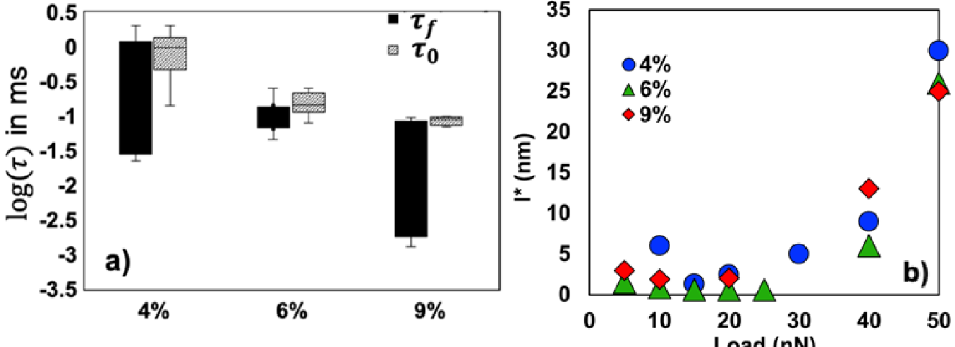
Figure 12. Parameters of the viscous-adhesive friction model for PAAm hydrogels (adhesive component). ( a ) Characteristics times for bond formation and rupture ( 𝜏 𝑓 and 𝜏 0 , respectively) in logarithmic axis, for loads between 5 and 50 nN, and ( b ) yield length 𝑙 ∗ of 4%-, 6%- and 9%-PAAm hydrogels as a function of load. Data used with permission from Ref. [23]. The parameters shown here deviate from those in Ref. [23] because the results in this Figure were determined assuming that ℎ,𝑑 = 𝜉 𝑠 (see manuscript text).